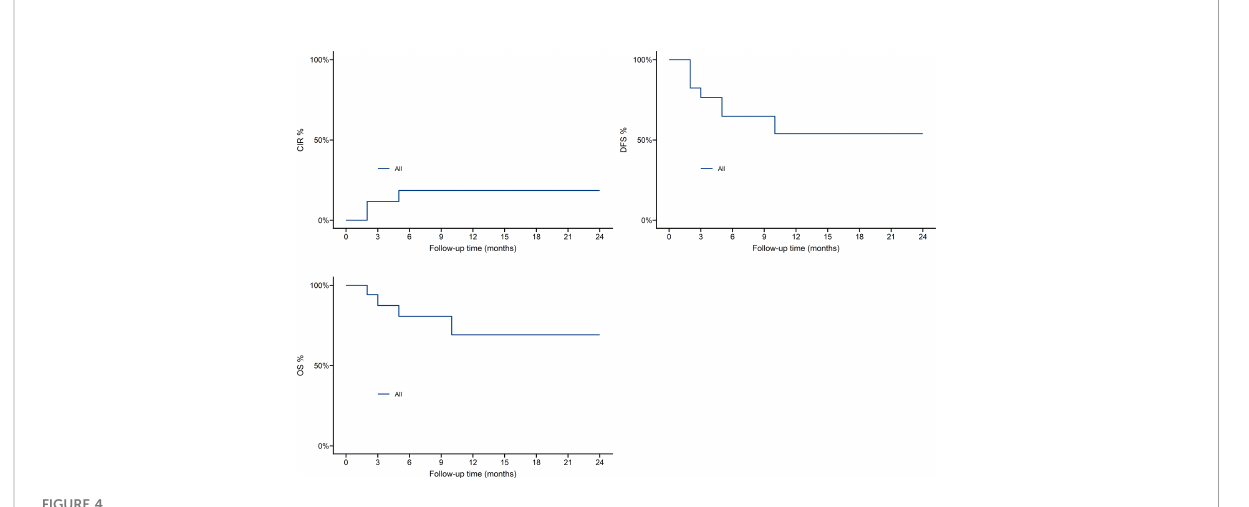
FIGURE 4 Survival outcomes in 17 patients.